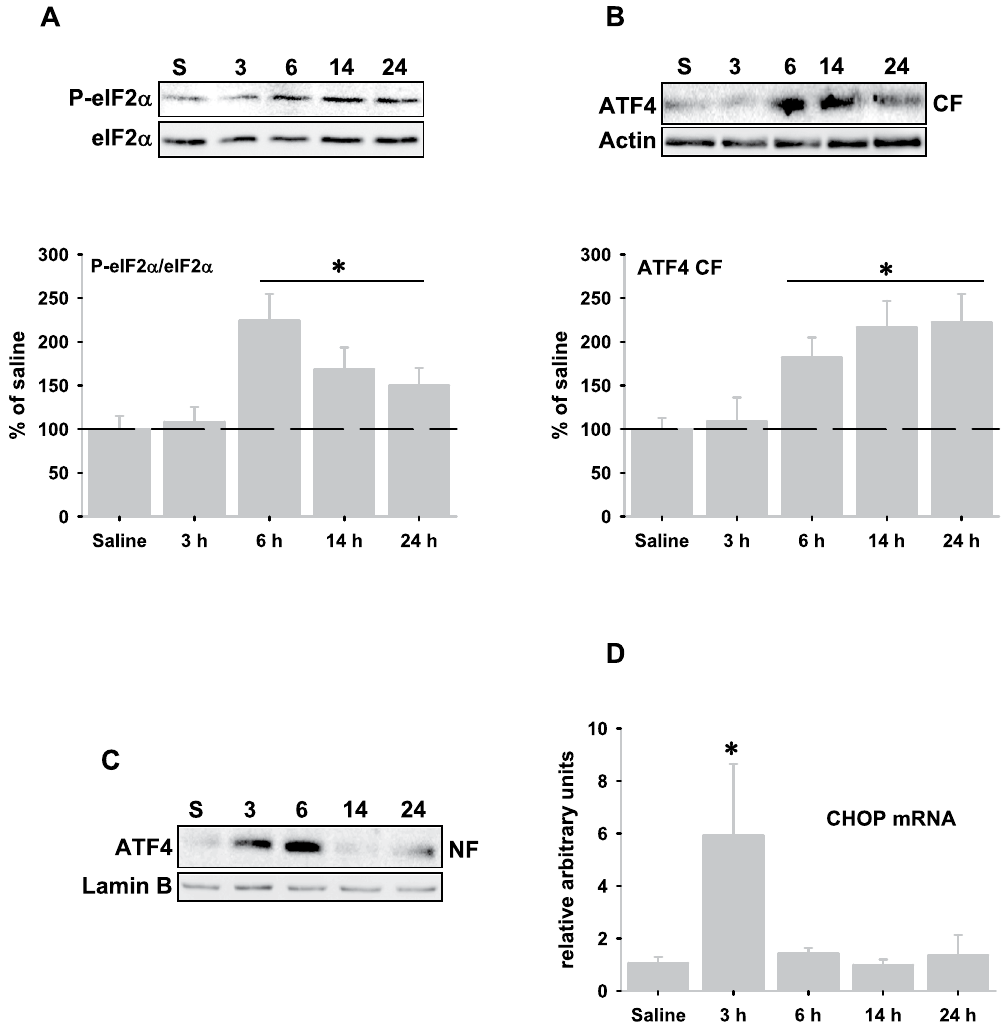
Figure 5. PERK pathway is activated following LPS injection. ( A ) Representative western blot of the phospho- eIF2 α (P-eIF2 α ) and eIF2 α proteins expressed in the cytosolic fractions after LPS injection (upper panel), and graphical representation of the P-eIF2 α /eIF2 α ratio in the cytosolic fractions determined by optical density analysis (lower panel). ( B ) Representative western blot of the ATF4 expression in the cytosolic fractions after LPS-injection (upper panel), and graphical representation of ATF4 expression in the cytosolic fractions determined by optical density analysis (lower panel). ( C ) Representative western blot corresponding to the transcription factor ATF4 in the nuclear fractions of the same animals following LPS-injection. Note the presence of nuclear ATF4 at 3 hours, preceding cytosolic ATF4 accumulation. ( D ) mRNA expression of the pro-apoptotic factor CHOP analyzed by RT-real time PCR after LPS-injection. Note the short time expression of CHOP mRNA. Data are presented as mean ± SD (n = 4) of percentage of variation relative to controls. * p < 0.05, significant differences compared with control (saline-injected)